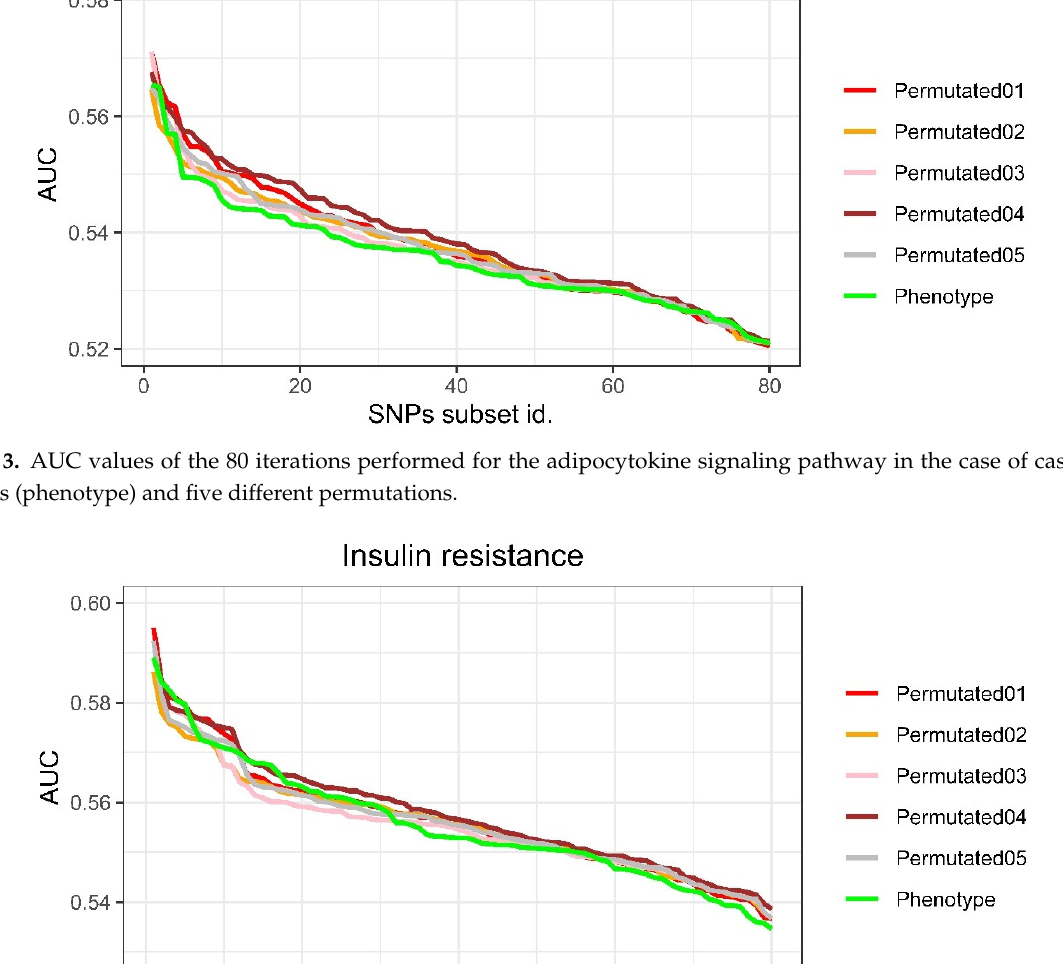
Figure 4. AUC values of the 80 iterations performed for the insulin resistance pathway in the case of cases and controls (phenotype) and five different permutations.